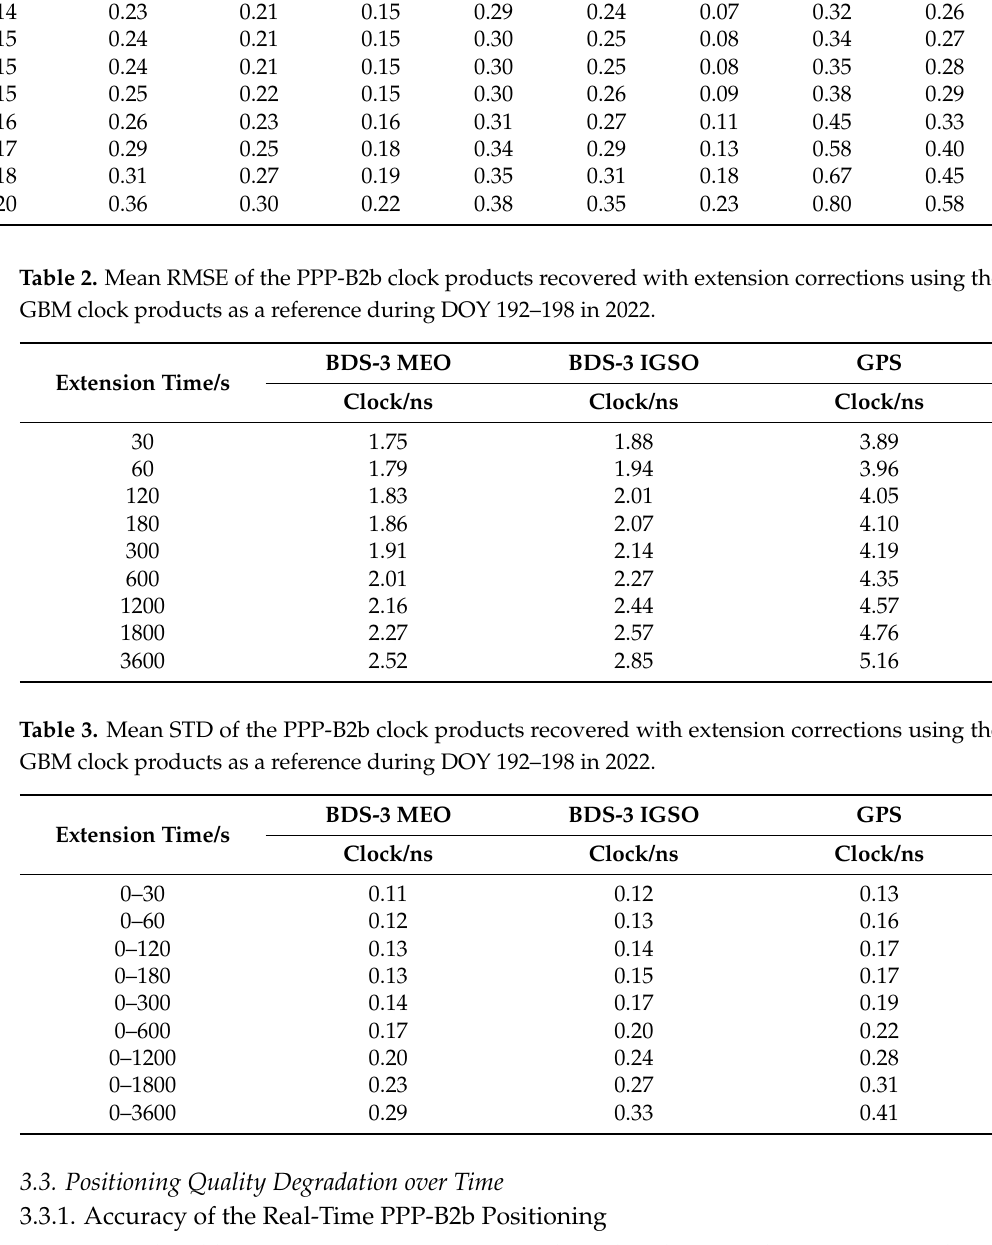
time observations at five stations. The specific processing strategies adopted in the PPP and locations of the stations are listed in Tables 4 and 5,